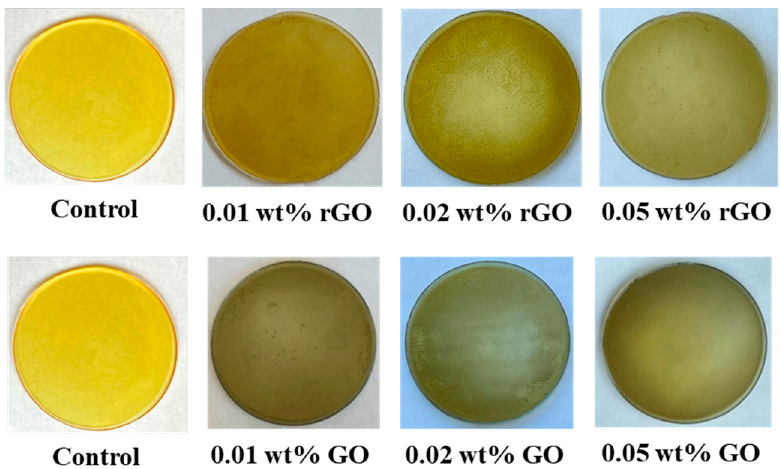
Figure 1. PU films containing different amounts of GO and rGO.